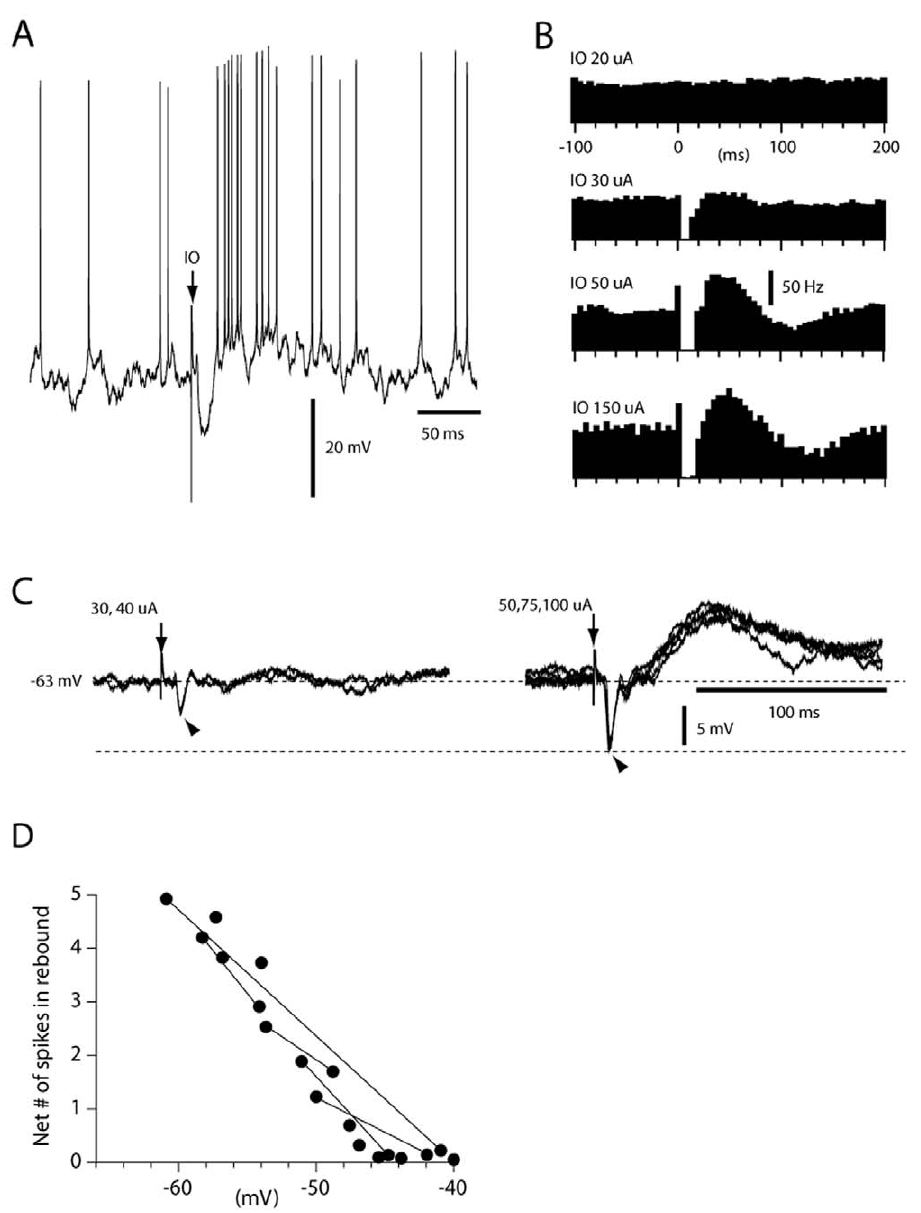
Figure 6. IO-evoked rebound responses. (A) Sample raw trace of rebound response evoked by maximal IO stimulation recorded at resting potential. (B) Spike responses evoked by subthreshold, submaximal, maximal and supramaximal IO stimulation (20, 30, 50 and 150 uA). Bin width, 5 ms. (C) Averages of responses evoked from the IO at different stimulation intensities recorded from another DCN neuron that was hyperpolarized to prevent spiking, Note all-or-nothing character of the rebound response as the IPSP (arrowheads) became maximal. (D) Relationship between membrane potential and the magnitude of the rebound response (expressed as net number of spikes, beyond prestimulus baseline, per stimulation). Lines indicate data obtained from the same cell at different membrane potentials.